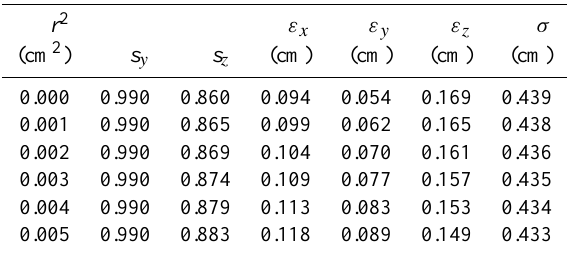
Table 4. Validation parameters and random errors estimated for location analysis for six assumed values of the correlated part of the representativeness error r 2